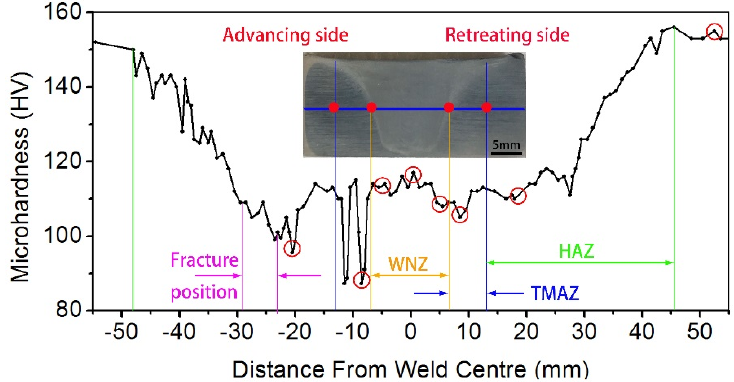
Figure 2. Microhardness profile along the middle section of the weld, the inset is a photograph of the corresponding FSW joint, the circled hardness’ were selected for transmission electron microscope (TEM) examination.